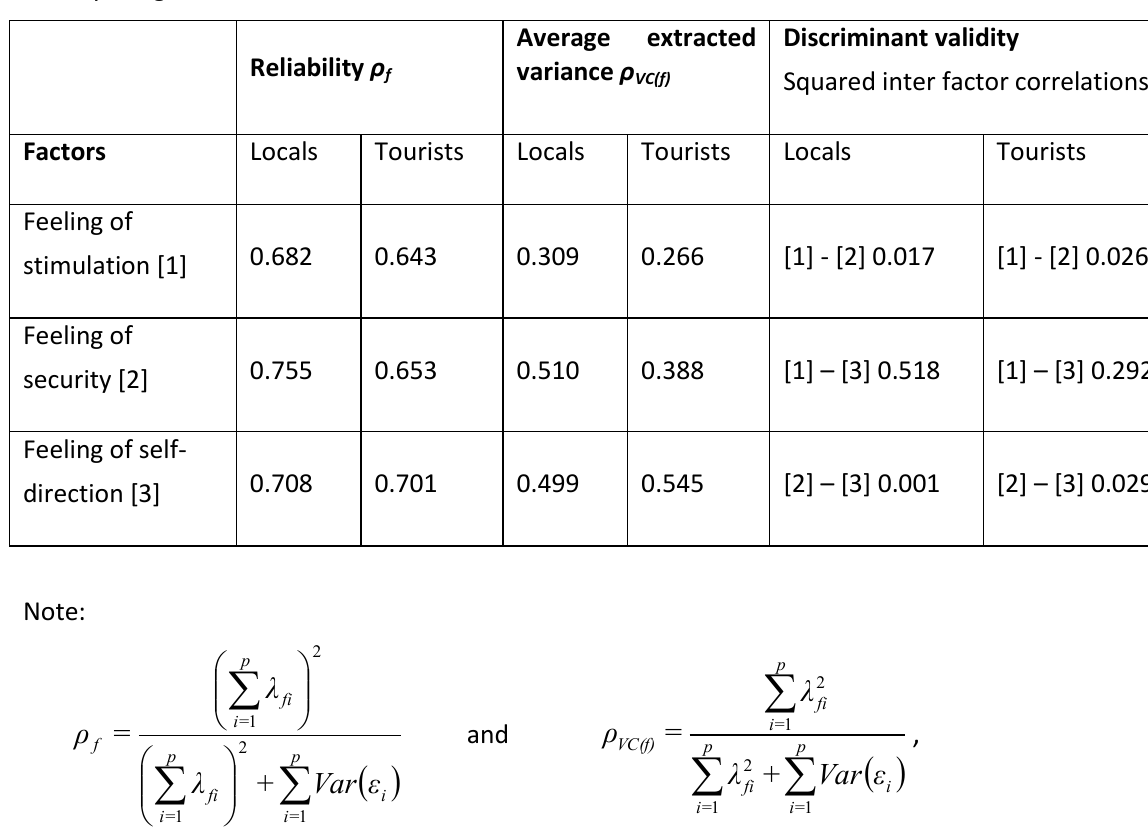
Table 5: Obtained values for the factor reliability, average extracted variance and discriminant validity are